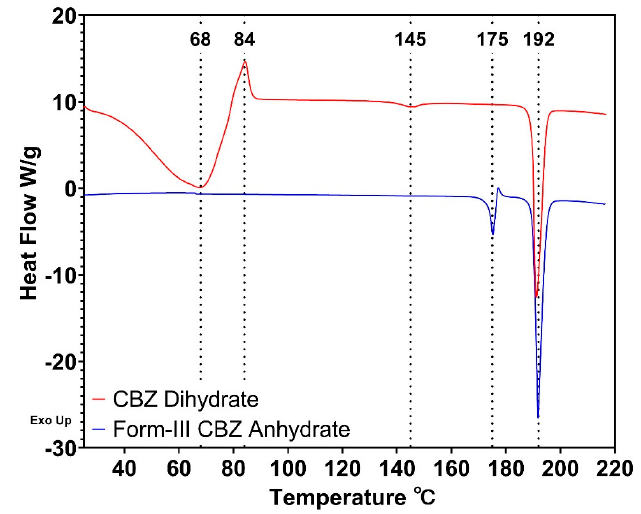
Figure 1. DSC thermograms of CBZ dihydrate (red) and form-III CBZ anhydrate (blue).